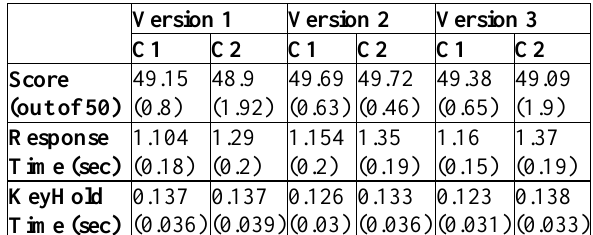
Table 8 Averaged performance (±SD) metric values for the 3